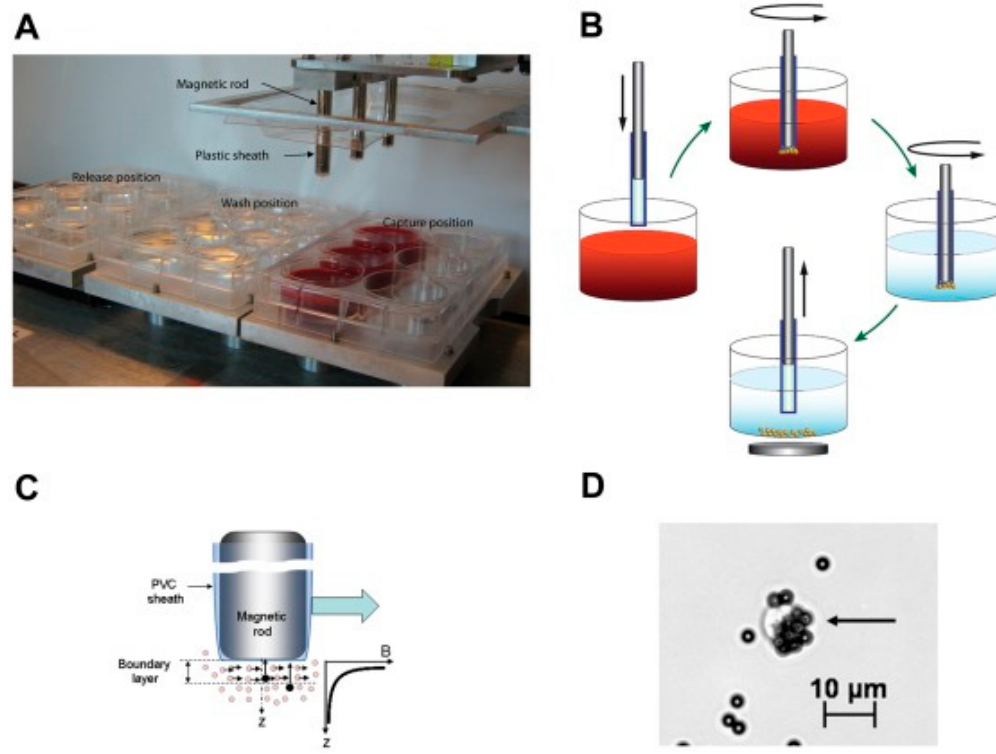
Figure 4. Magnetic sweeper device and cell isolation steps. ( A ) Magnetic sweeper device showing magnetic rods sheathed in plastic above the capture, wash and release stations. ( B ) A diagrammatic view of magnetic sweeper cell isolation protocol. ( C ) A controlled shear force produced by the movement of the magnetic rods in the wash station releases non-specifically bound blood cells. ( D ) Photomicrograph of a CTC labeled with 4.5 μ m immunomagnetic beads. (Reprinted from [44]).